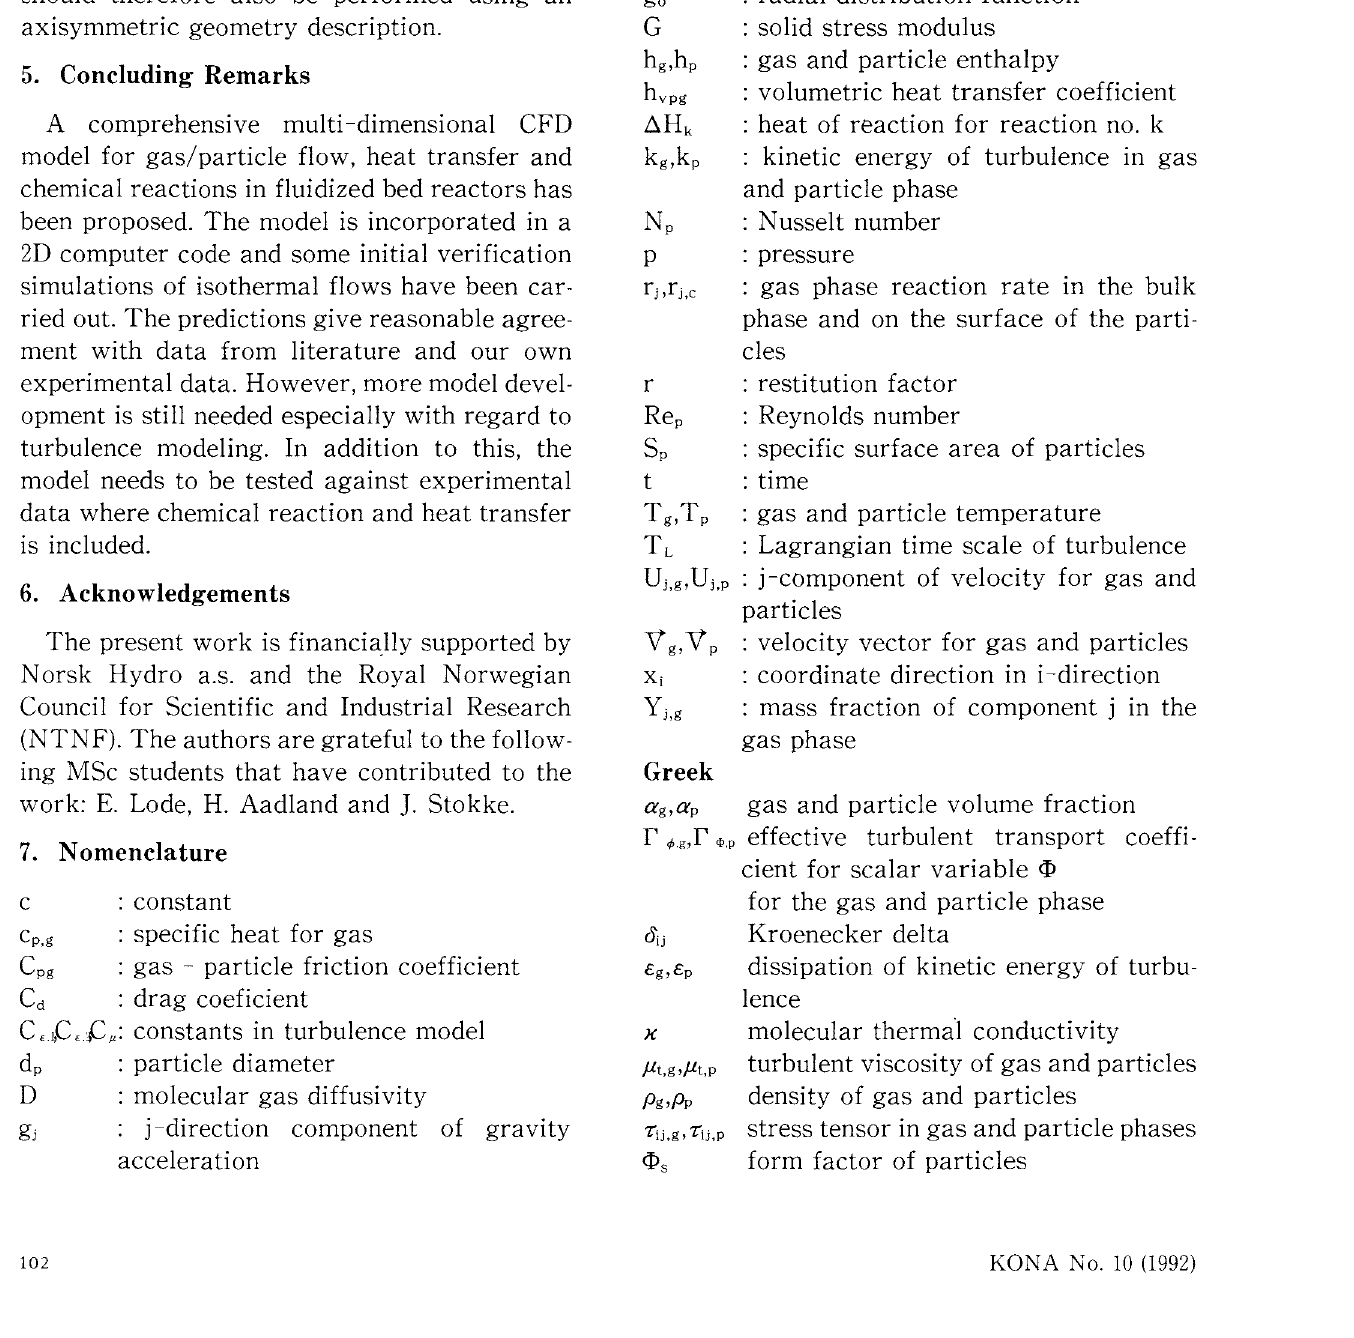
Fig. 5 Measured and predicted profiles of particle velocity as a function of distance across the tube diameter at three heights from the distributor